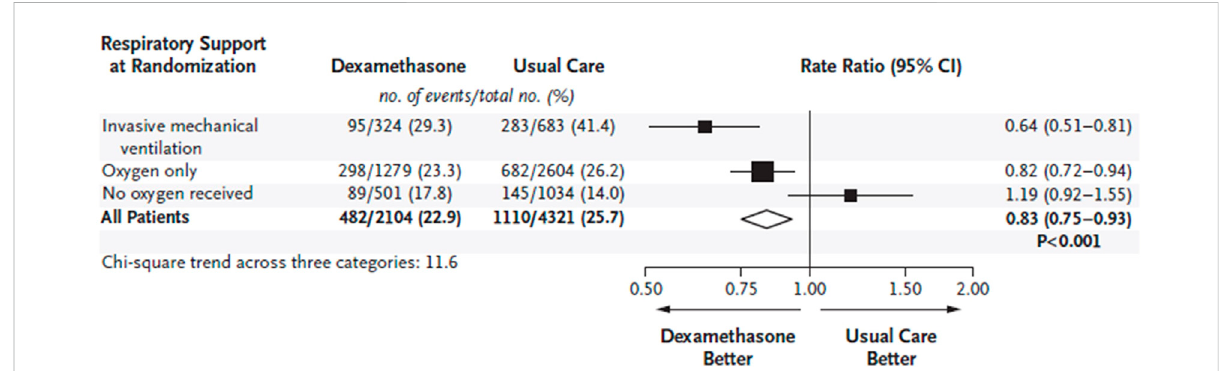
FIGURE 3 Effect of dexamethasone on 28-days mortality according to respiratory support at the time of randomization in hospitalized patients with COVID-19. Rate ratios are plotted as squares, with the size of each square proportional to the amount of statistical information that was available. Horizontal lines represent 95% con fi dence intervals. (from RECOVERY Collaborative Group Horby et al.,